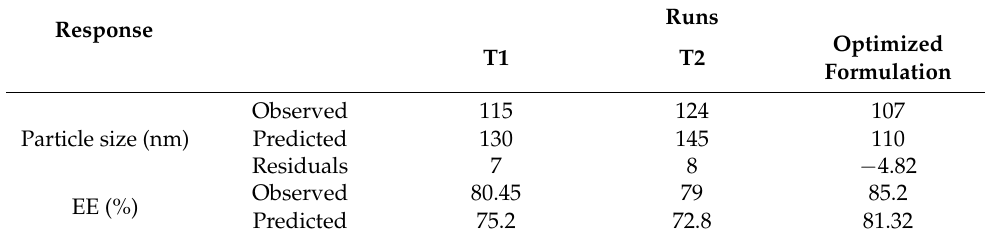
Table 3. Evaluation of design checks point for T1 and